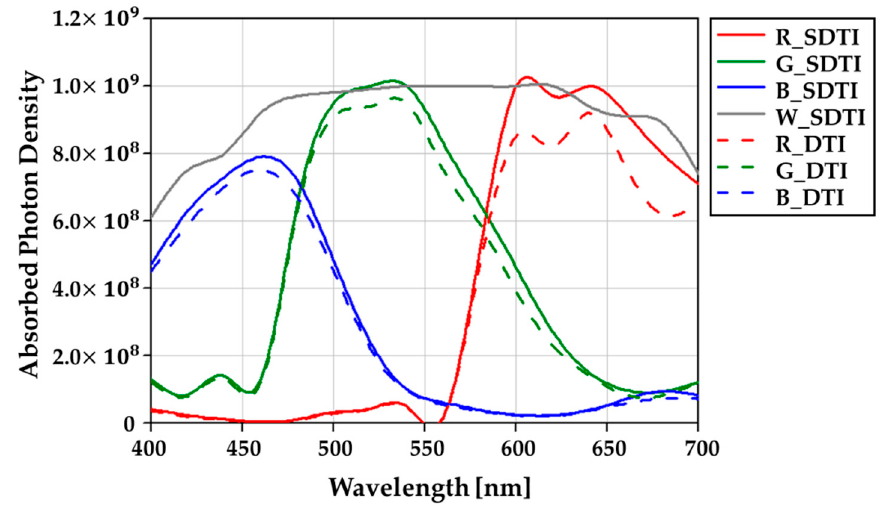
Figure 7. The simulated absorbed photon density with the wavelengths from 400 nm to 700 nm. The light is incident at 0 ◦ . The solid line shows the results of the quad-WRGB CFA with S-DTI / S-WG. The dotted line shows the results of the quad-Bayer CFA with DTI / WG. The pixel size is a 0.8 μ m .